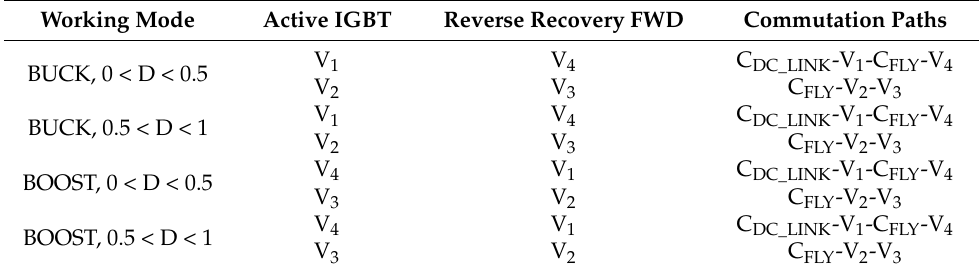
Figure 6. Commutation paths of FC ‐ 3L ‐ BDC. ( a ) Boost mode, 0.5 < D < 1 (V 4 switching). ( b ) Boost mode, 0.5 < D < 1 (V 3 switching). Table 2. The switch statuses and commutation paths of different working